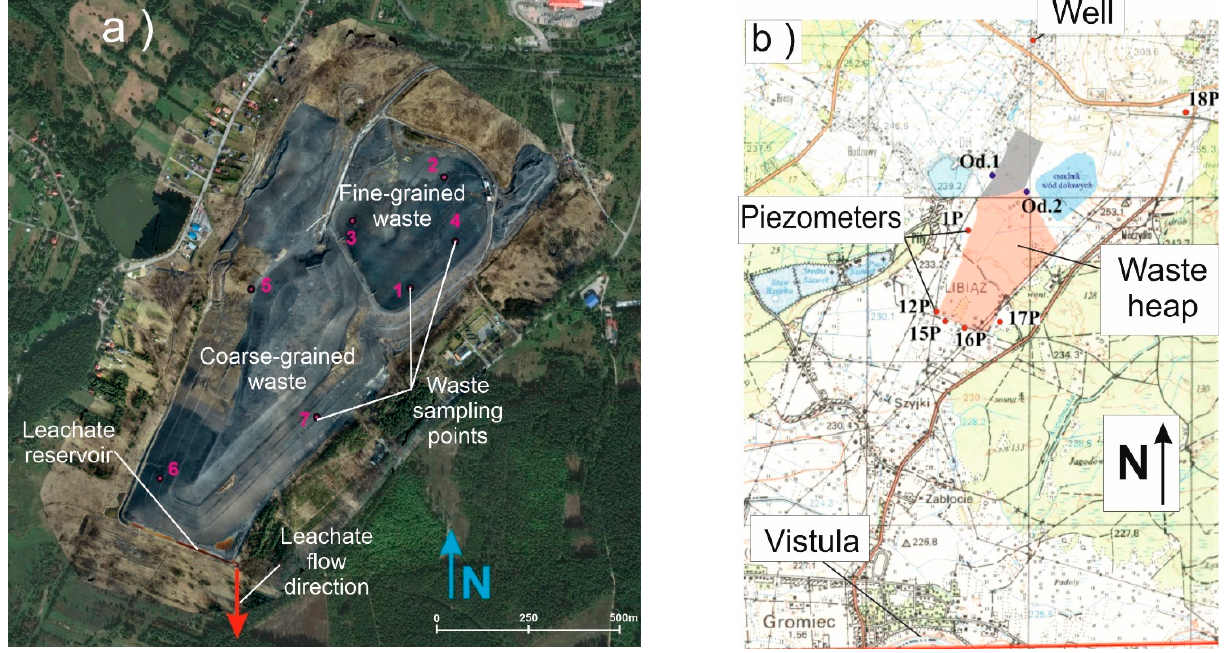
Figure 1. Images of: ( a ) the coal waste heap; ( b ) the location of the Vistula and piezometers near the heap [19].